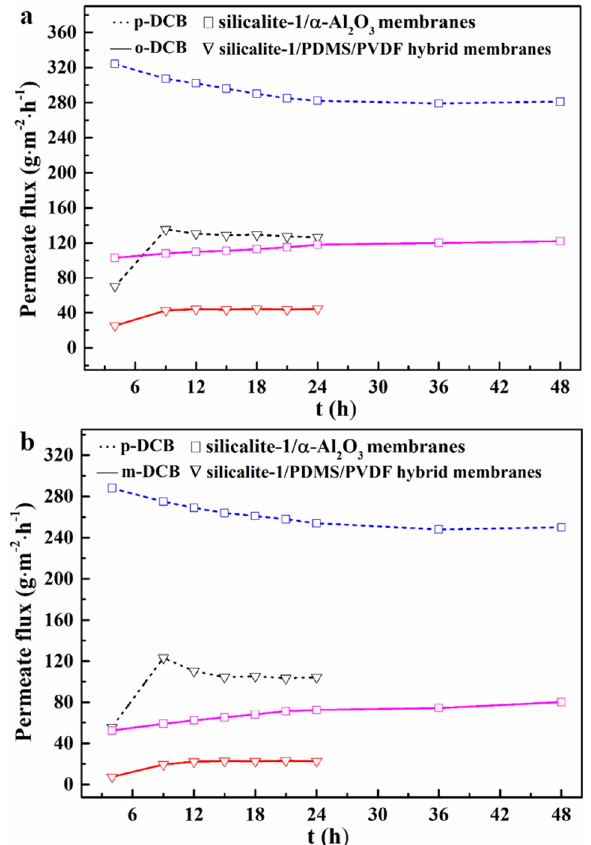
Figure 12. Pervaporation flux results of the silicalite-1/ α− Al 2 O 3 membranes [3] and the silicalite- 1/PDMS/PVDF hybrid membranes in binary − isomers solutions (of equal molar content): ( a ) p/o − DCB; ( b ) p/m −